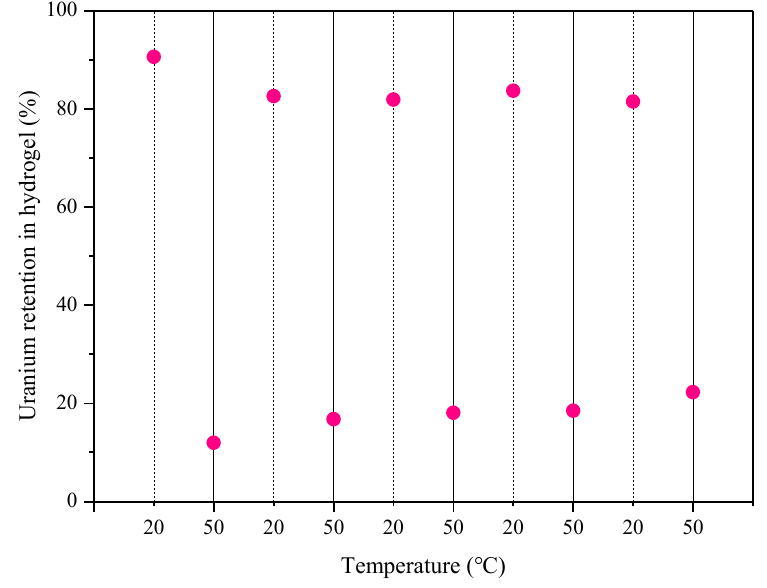
Figure 15. The uranium retention in hydrogel of temperature swing adsorption-desorption.